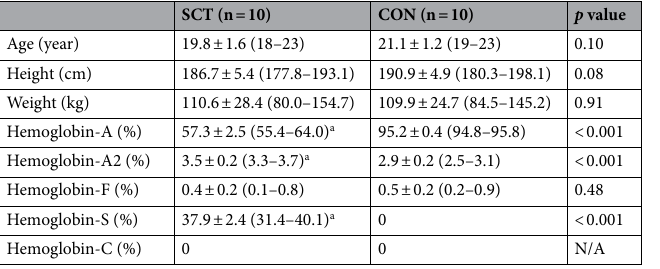
Table 1. Physical characteristics of participants by groups. Data are presented as mean ± SD (Range). SCT sickle cell trait, CON position-matched control group. a Significant difference between groups.